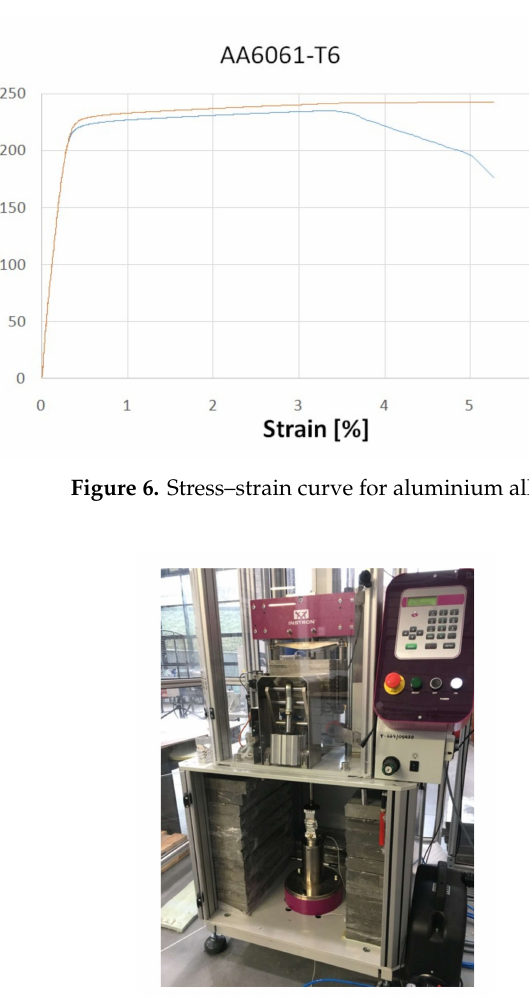
Figure 7. The impact drop tower for dynamic loading